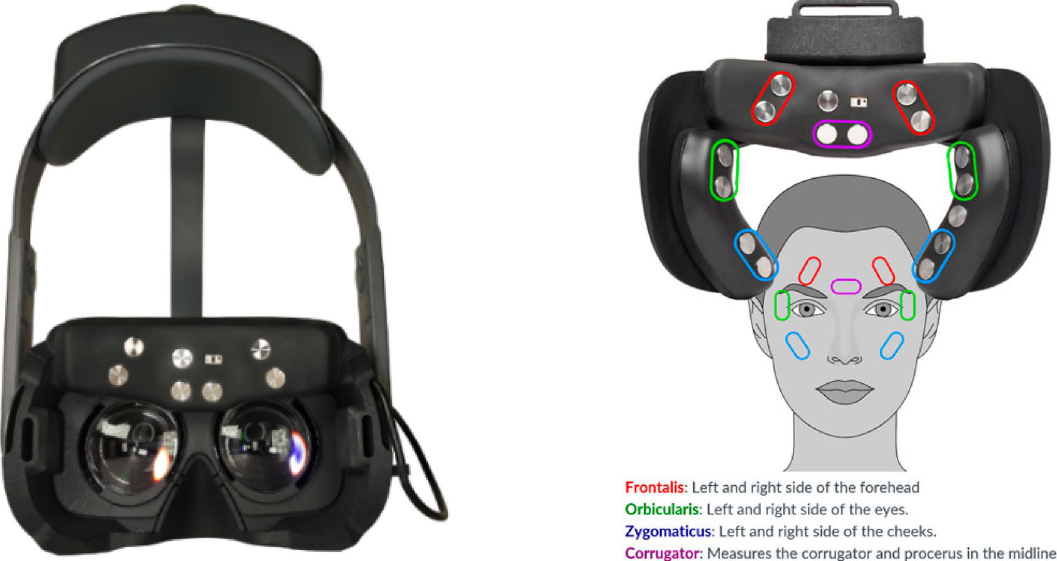
Figure 9. The figure on the left depicts the emteqPro mask installed into the Pico Neo 2 Eye Virtual Reality (VR) headset. The figure on the right depicts the mapping between emteqPro’s EMG sensors and facial